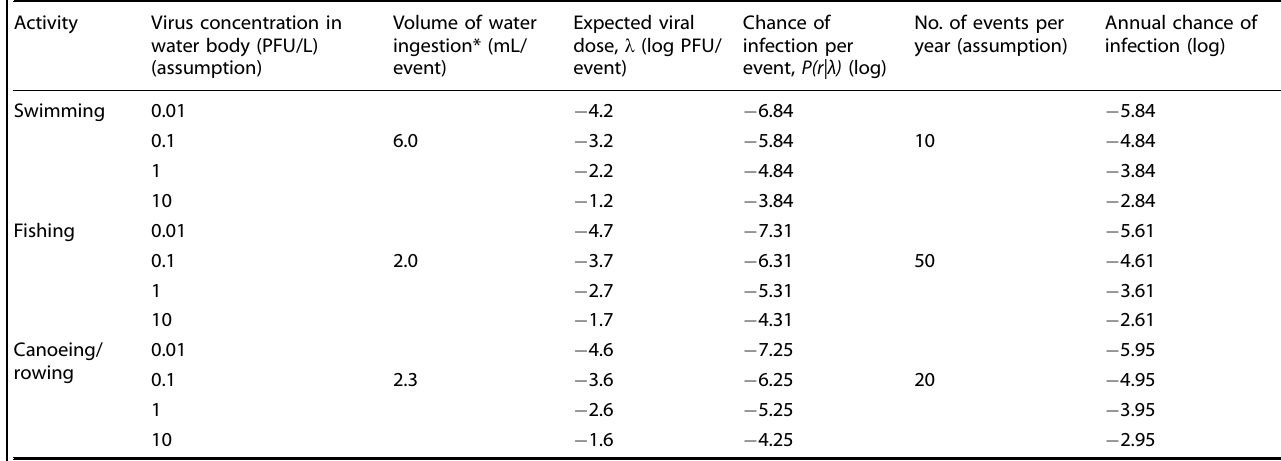
Table 3. Expected dose and probability of infection to SARS-CoV-2 for various water activities under various viral concentration scenarios.